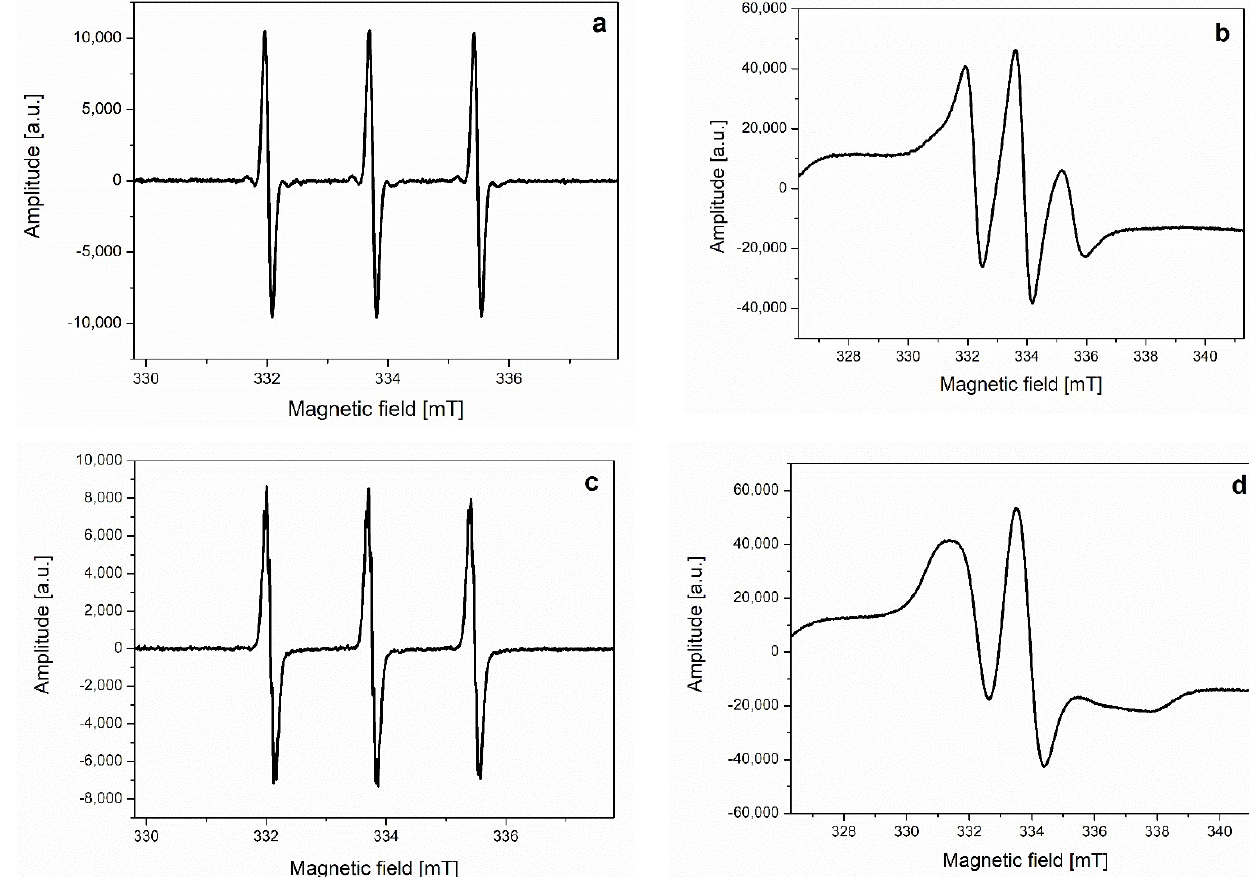
Figure 2. ESR spectra of TEMPO ( a , b ) and TEMPOL ( c , d ) spin probes with yeast cells recorded at 295 K ( a , c ) and 240 K ( b , d